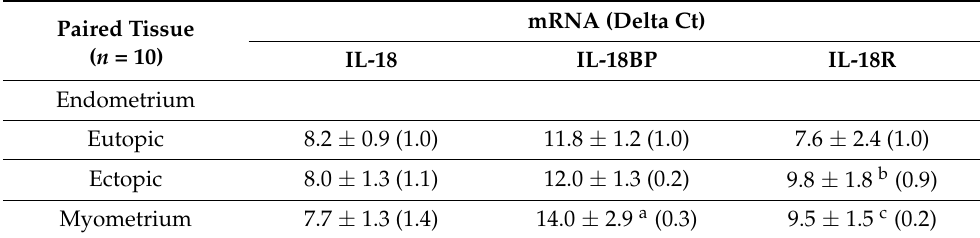
Table 1. Expression of IL-18 system mRNA.